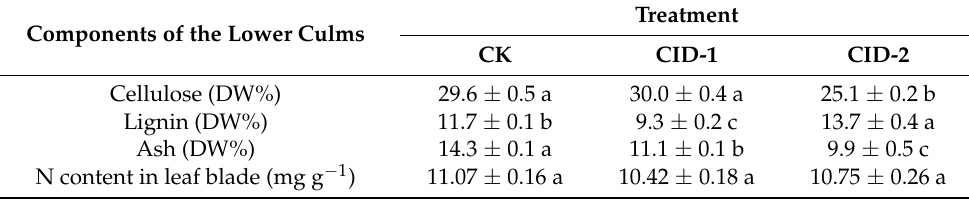
Table 4. Components of the lower culms and N content in leaf blade of rice plants under different irrigation regimes during the rice growing season of 2013.